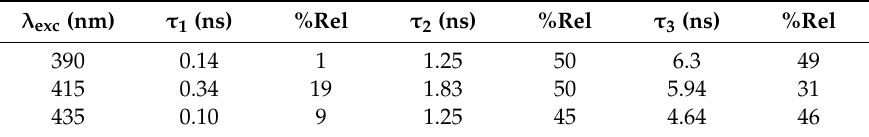
Table 3. Fit parameters of the decay kinetic curves excited at diverse excitation wavelengths for e-GQDs formed from oxacillin and EDA as carbon and nitrogen